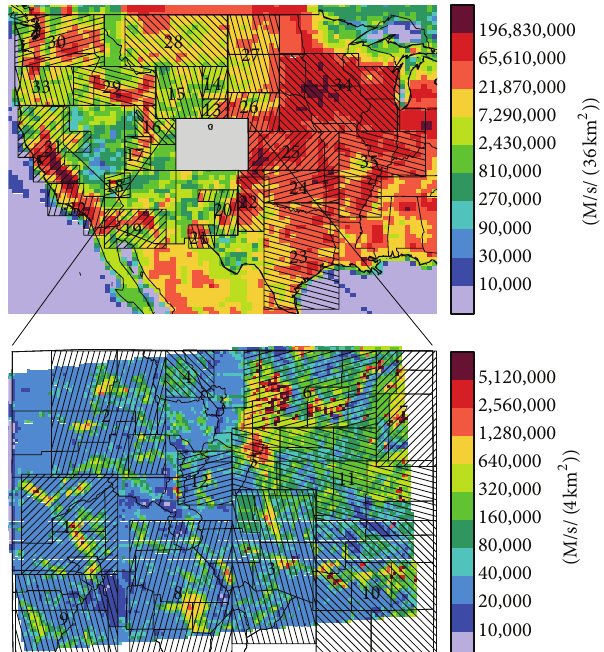
Figure 11: Source areas used for TrMB modeling and ammonia emissions [32] used for RoMANS II chemical transport modeling on the 36 km (a) and 4 km domains (b). The distance from the eastern edge of the map to the Pacific Coast in panel (a) is approximately 4000km. In panel (b), Colorado is approximately 610km from east to